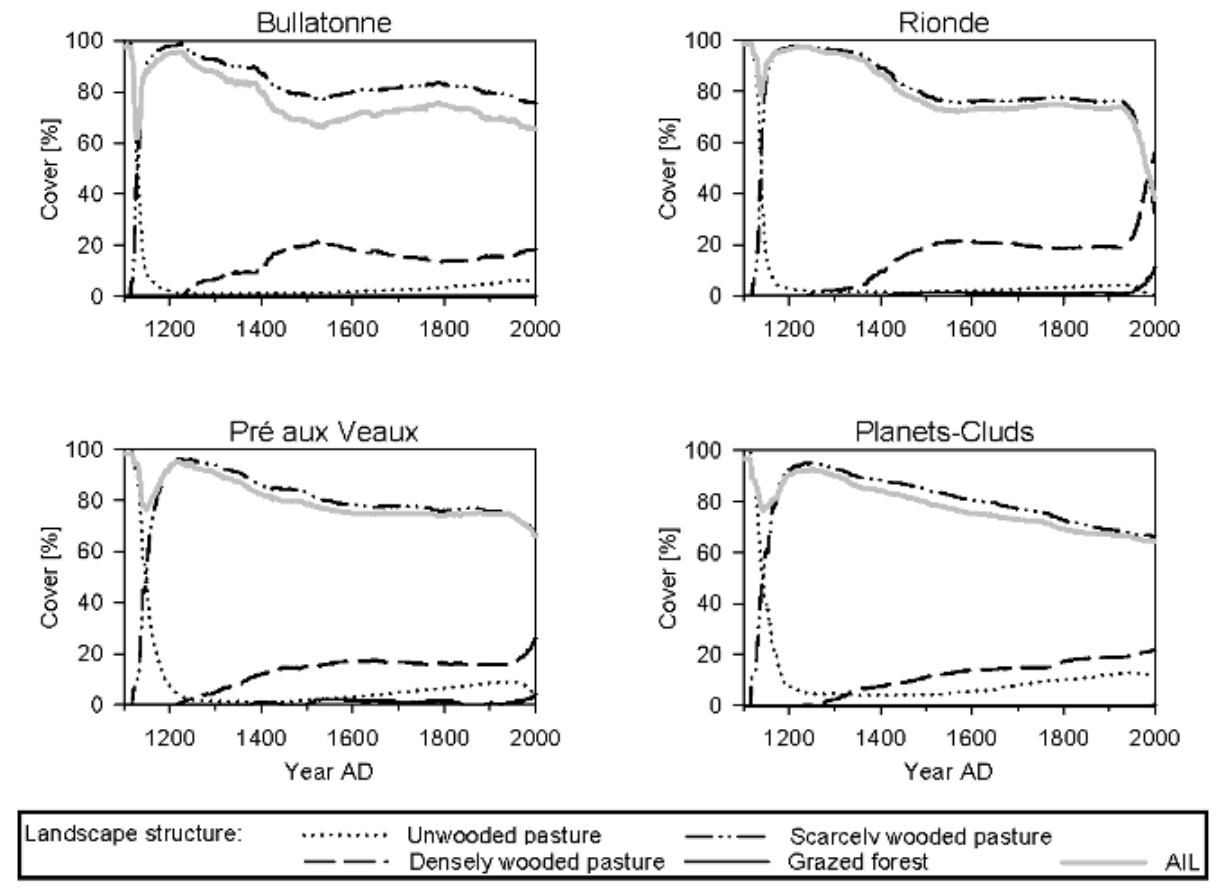
Fig. 5 . Landscape structural dynamics in long-term historical simulations of the pastures Bullatonne, Rionde, Pré aux Veaux, and Planets-Cluds. Simulations start from clearings in 1100 AD and follow historical time series of grazing and climate. The four phytocoenosis types used for display are defined in Table 3. The landscape aggregation index AIL is computed after He et al. (2000) as the weighted mean of aggregation indexes AI computed for each phytocoenosis type. AI assumes that a class with the highest level of aggregation is comprised of pixels sharing the most possible edges (simple clumped pattern). A class whose pixels share no edges (completely disaggregated complex pattern) has the lowest level of